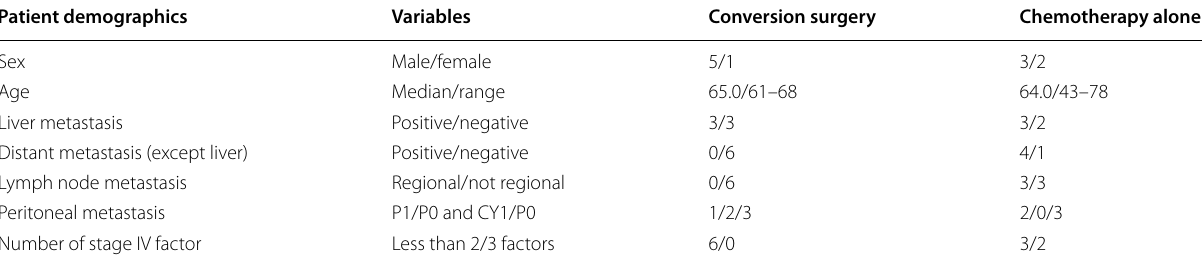
Table 2 Patient characteristics of conversion surgery group and chemotherapy alone